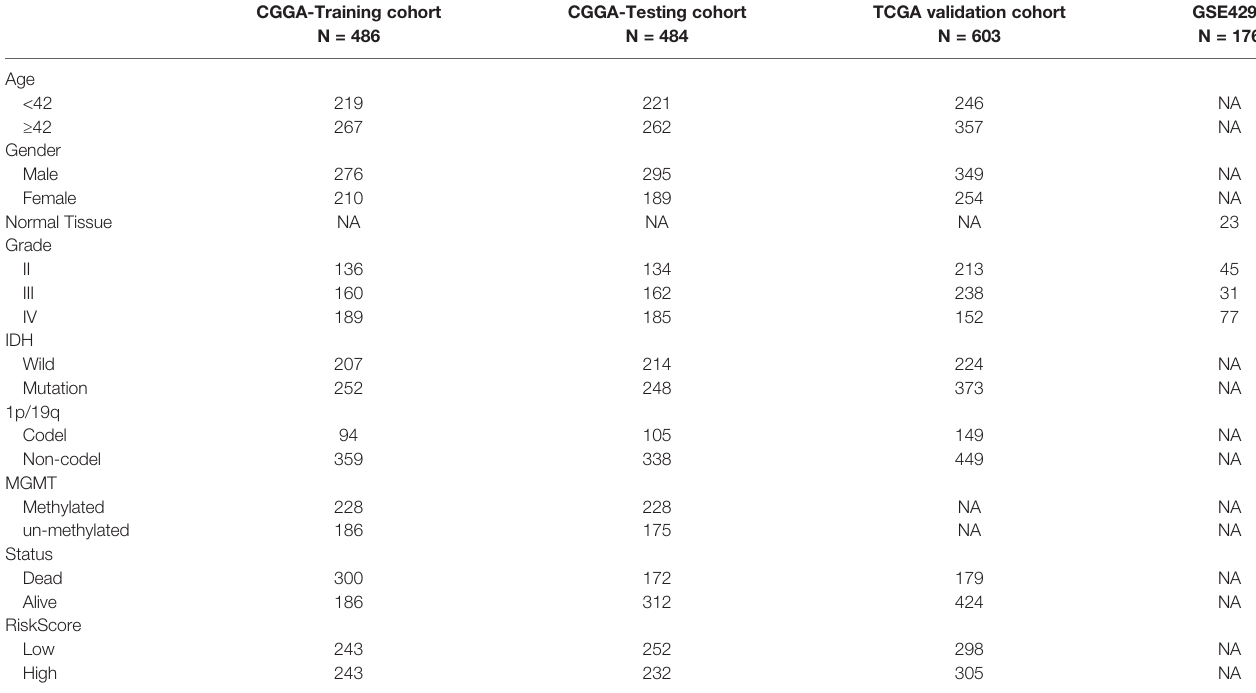
TABLE 1 | Clinicopathological characteristics of glioma patients from the CGGA,TCGA, and GEO databases. CGGA-Training